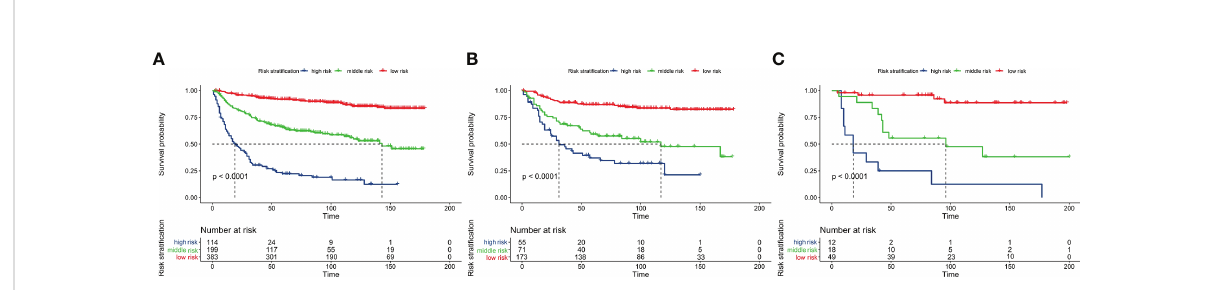
FIGURE 6 Overall survival analysis using Kaplan-Meier curves from the nomogram-based risk strati fi cation in the training, internal-validation, and external- validation groups (A – C)